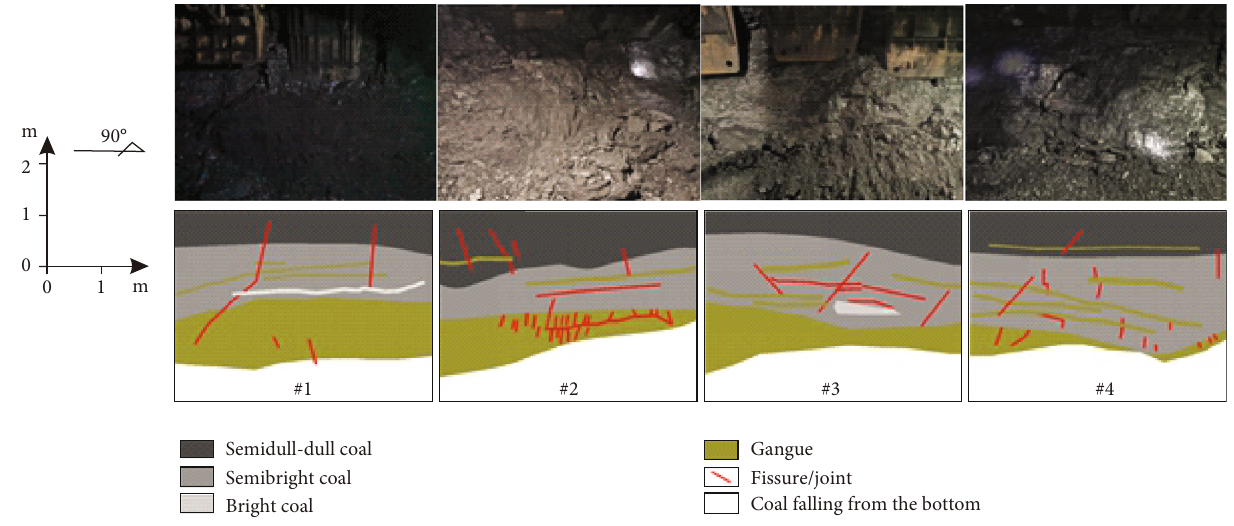
Figure 3: Fractures developed in underground coal seams in di ff erent locations. The lower fi gure is a schematic, where white areas represent coal falling out from the bottom, red lines represent exogenous joints, gray-yellow areas represent mudstone gangue, and other colors represent coal strati fi cation of di ff erent macroscopic coal types.